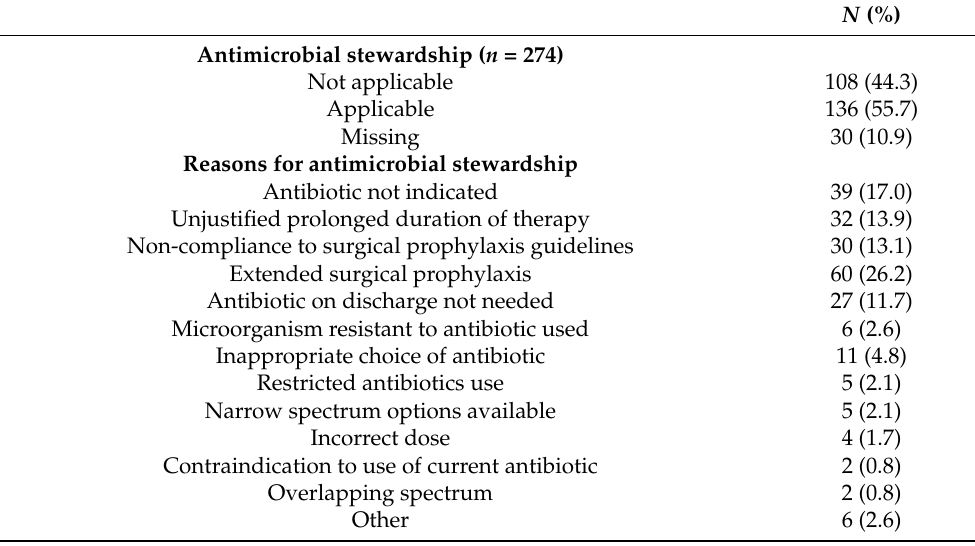
Table 4. Antibiotic